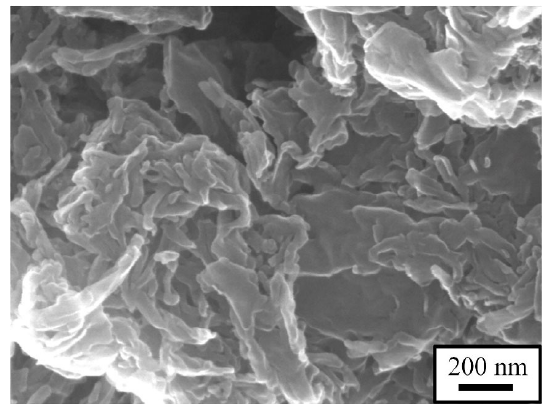
Fig. 1 SEM image of LCG